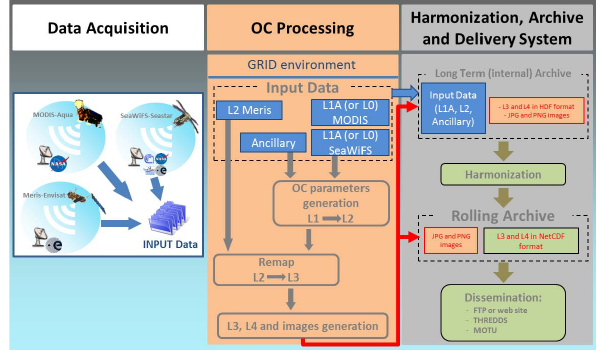
Fig. 1. GOS OC system architecture based on three main mod- ules: data capture and acquisition facility from space agency ground segments (left panel); processing system (middle panel); data har- monization, archive and dissemination module (right panel). Blue blocks with white labels show the input data stored into the GOS in- ternal archive. Arrows, blocks and labels marked in red (right panel) display the output products stored within both the GOS internal and rolling